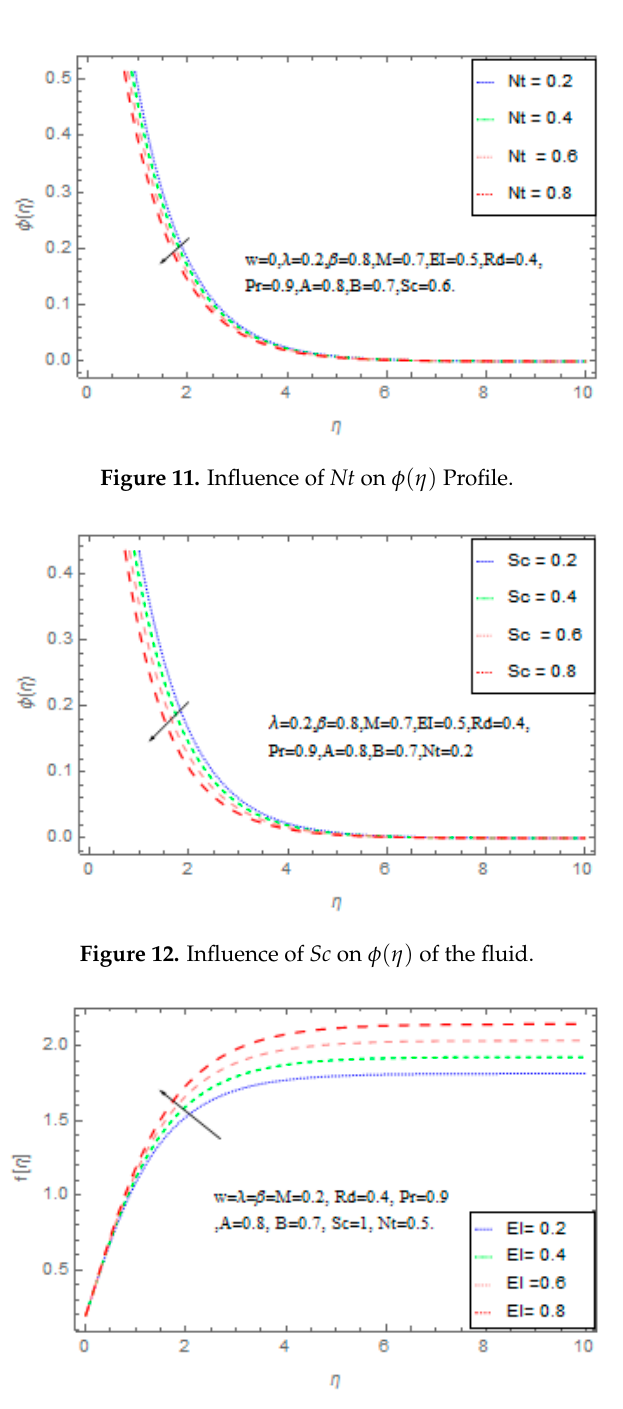
Figure 10. Influence of B on ( ) θ η Profile.